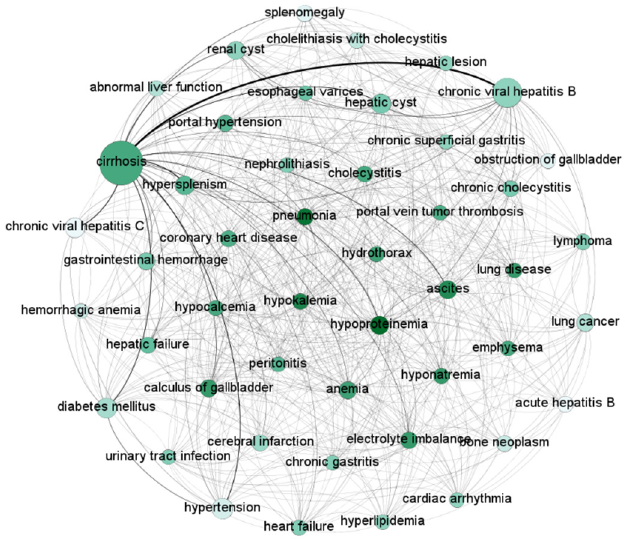
Figure 3. The HCC comorbidities